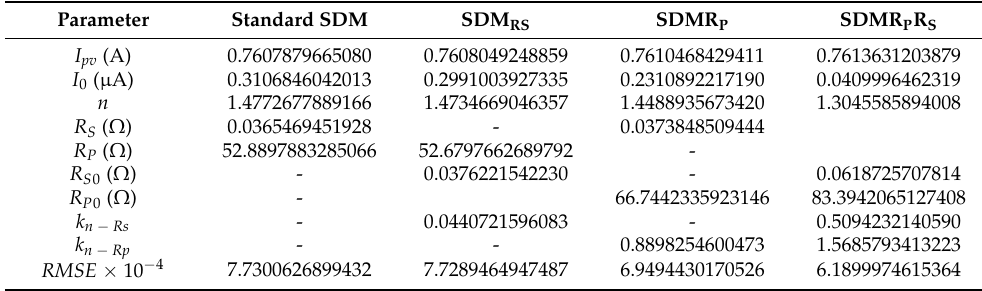
Table 1. Estimated parameters value for the proposed equivalent circuits for the investigated RTC France solar cell.